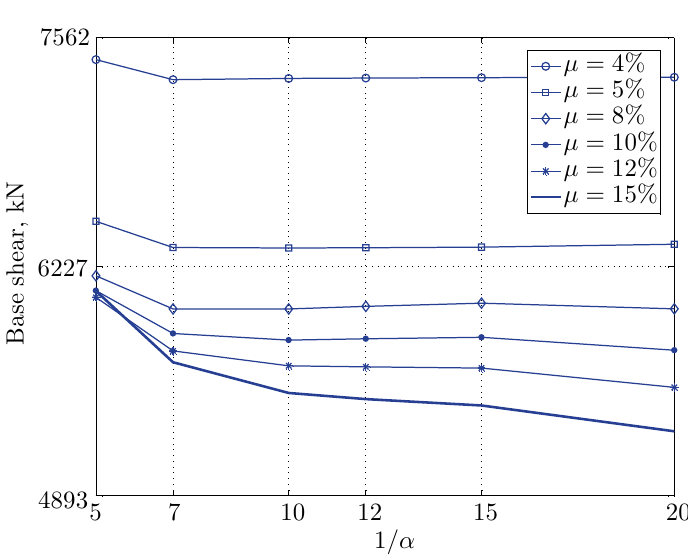
Figure 39. Maximum base shear for various isolation system parameters